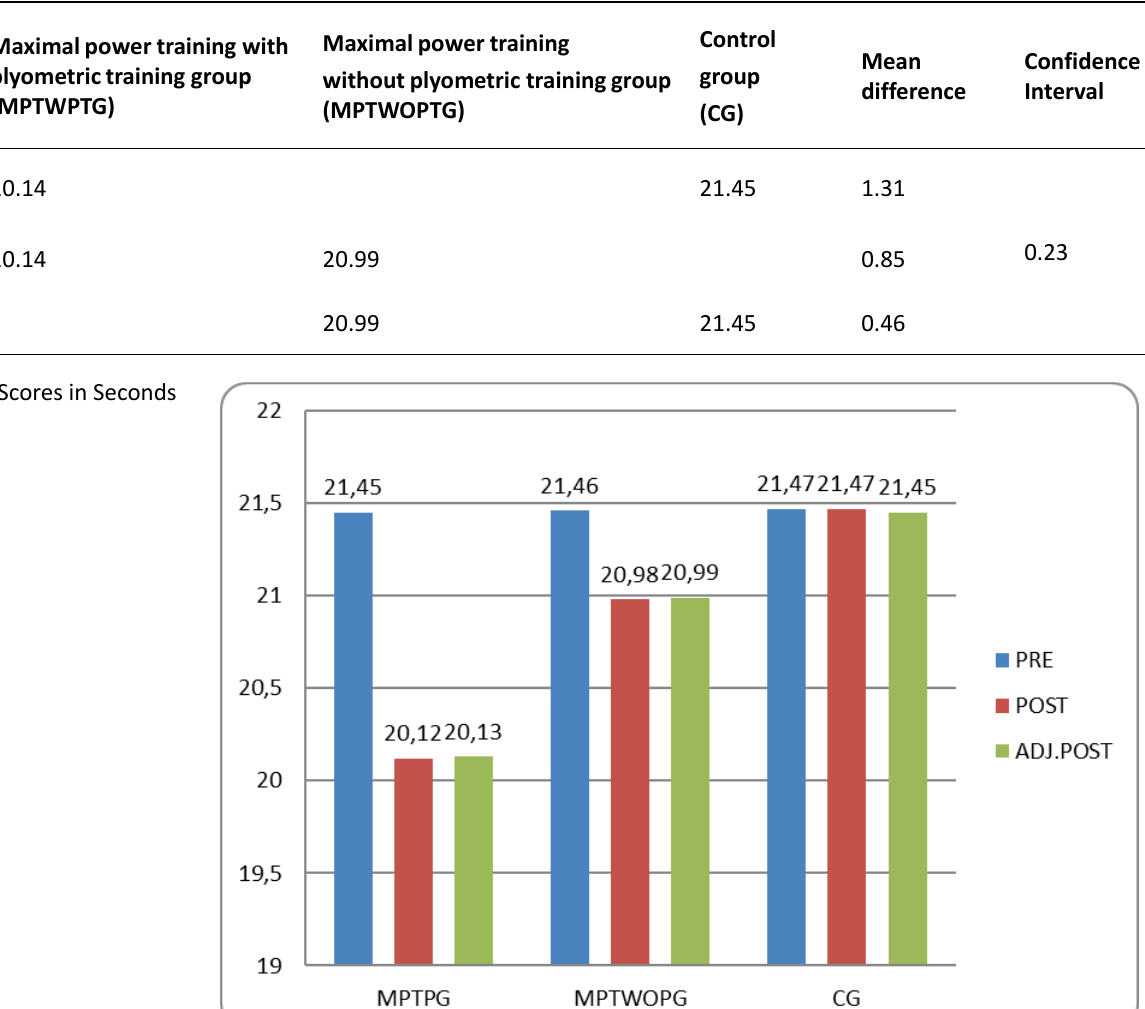
Table 3. Scheffee’s post hoc test for the differences between the paired adjusted post-test means of speed endurance Maximal power training with